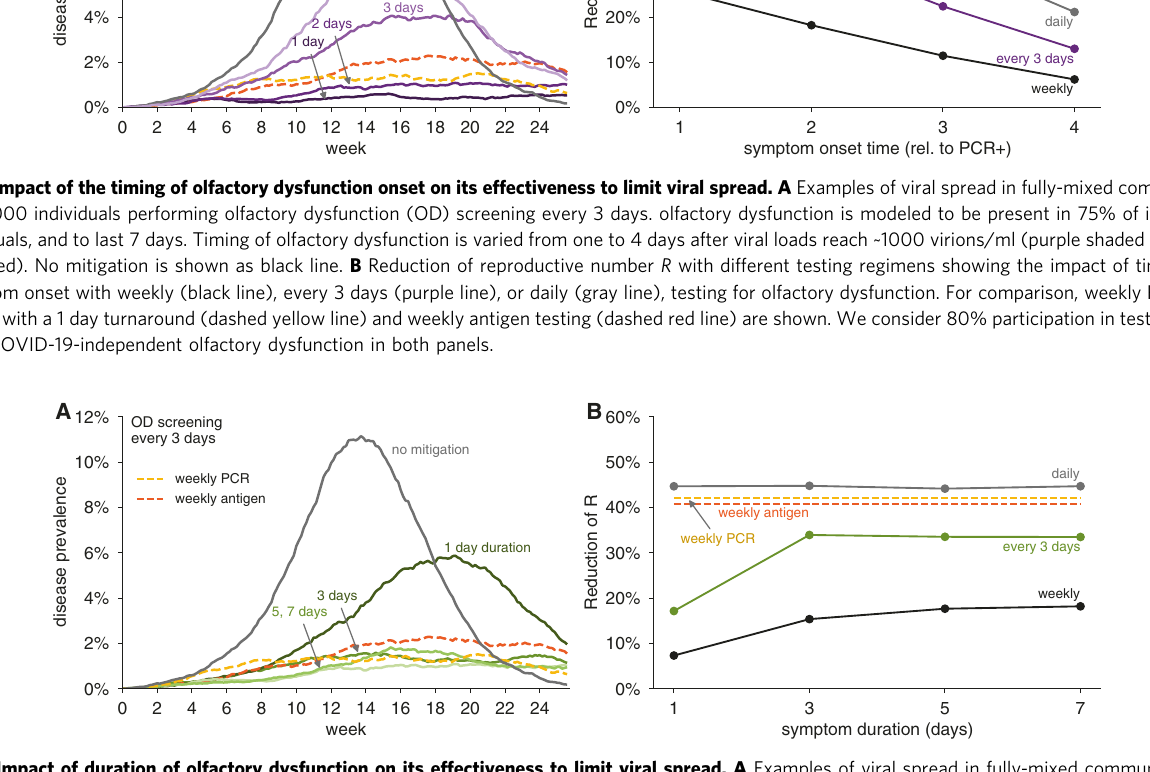
Fig. 3 Impact of duration of olfactory dysfunction on its effectiveness to limit viral spread. A Examples of viral spread in fully-mixed community of 20,000 individuals performing olfactory dysfunction (OD) screening every 3 days. Olfactory dysfunction is modeled to be present in 75% of infected individuals, and to begin 2 days after viral levels reach ~1000 virions/ml. Duration of olfactory dysfunction is varied from 7 days (lightest green), 5 days (light green), 3 days (green), to 1 day (dark green). No mitigation is shown as black line. B Reduction of reproductive number R with different testing regimens showing the impact of olfactory dysfunction duration with weekly (black line), every 3 days (green line), or daily (gray line), testing for olfactory dysfunction. For comparison, weekly RT-PCR testing with a 1 day turnaround (dashed yellow line) and weekly antigen testing (dashed red line) are shown. We consider 80% participation in testing and 20% COVID-19-independent olfactory dysfunction in both